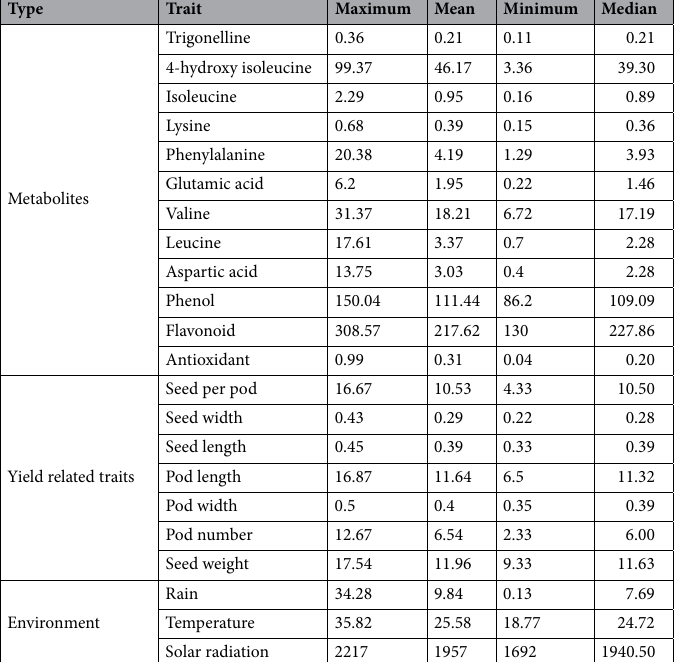
Table 1. Description of 21 measured yield related traits and metabolic traits in